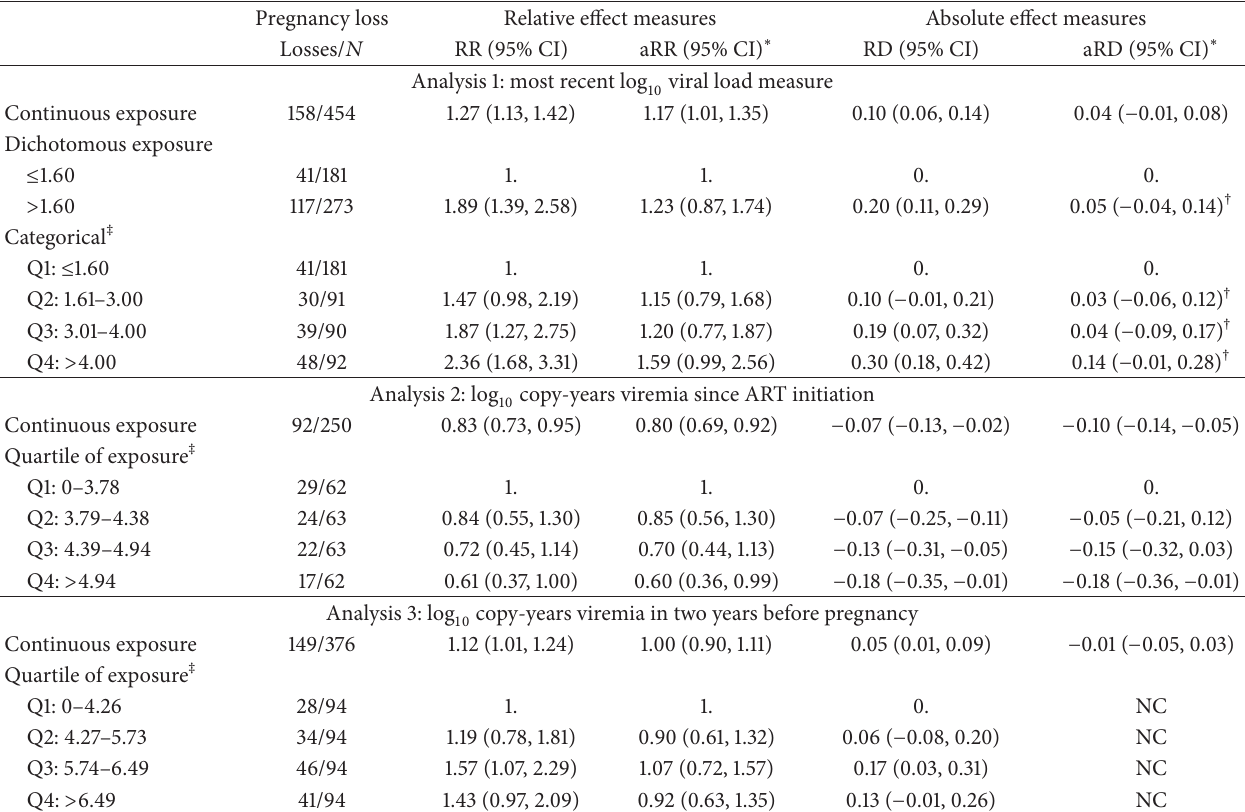
Table 2: Risk ratios and risk differences of the association of pregnancy loss with most recent cross-sectional viral load measure before the pregnancy ended ( 𝑁 = 454 ), log 10 copy-years viremia from ART initiation to conception ( 𝑁 = 250 ), and log 10 copy-years viremia in the two years prior to conception ( 𝑁 = 376